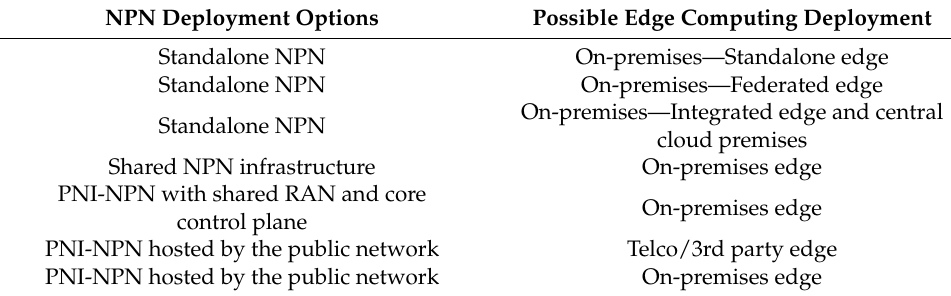
Table 1. Overview of the NPN deployment options and edge computing setups.